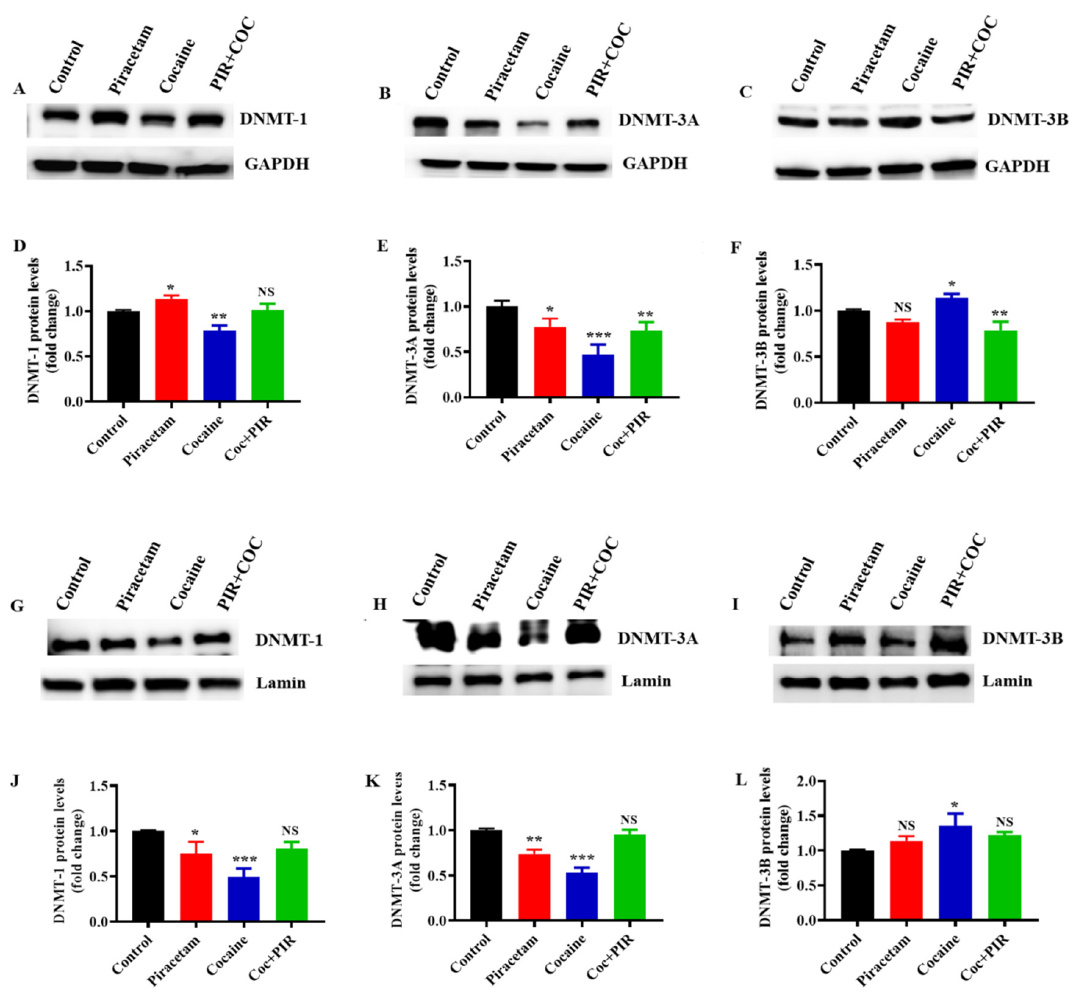
Figure 2. Piracetam reversed the impact of cocaine on DNMT protein expression in primary astrocytes. Human primary astrocytes were exposed to cocaine (1 µ M) and / or piracetam (10 µ M) for 24 h, and the total and nuclear Fractions were isolated. Representative blots ( A , G ) showing the expression of DNMT-1, ( B , H ) DNMT-3A and ( C , I ) DNMT-3B in the total and nuclear fractions. ( D – F , J – L ) Densitometric analysis of the level of each protein relative to the corresponding level of GAPDH or lamin as a loading control (fold change relative to the control). The data are expressed as the mean ± SD of three independent experiments. *** p < 0.001, ** p < 0.01, * p < 0.05, NS— nonsignificant.